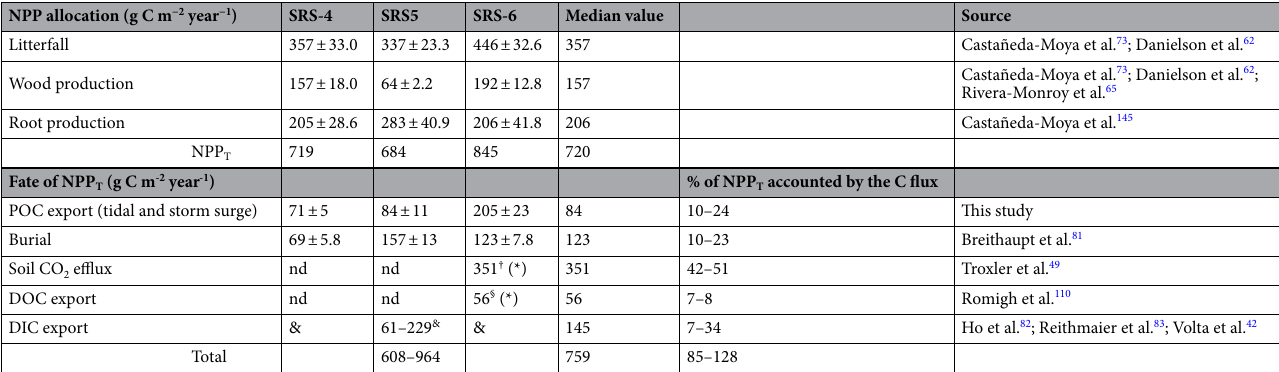
Table 2. Estimated carbon fluxes (g C m −2 year −1 ) (± SE) for riverine mangroves in the Shark River